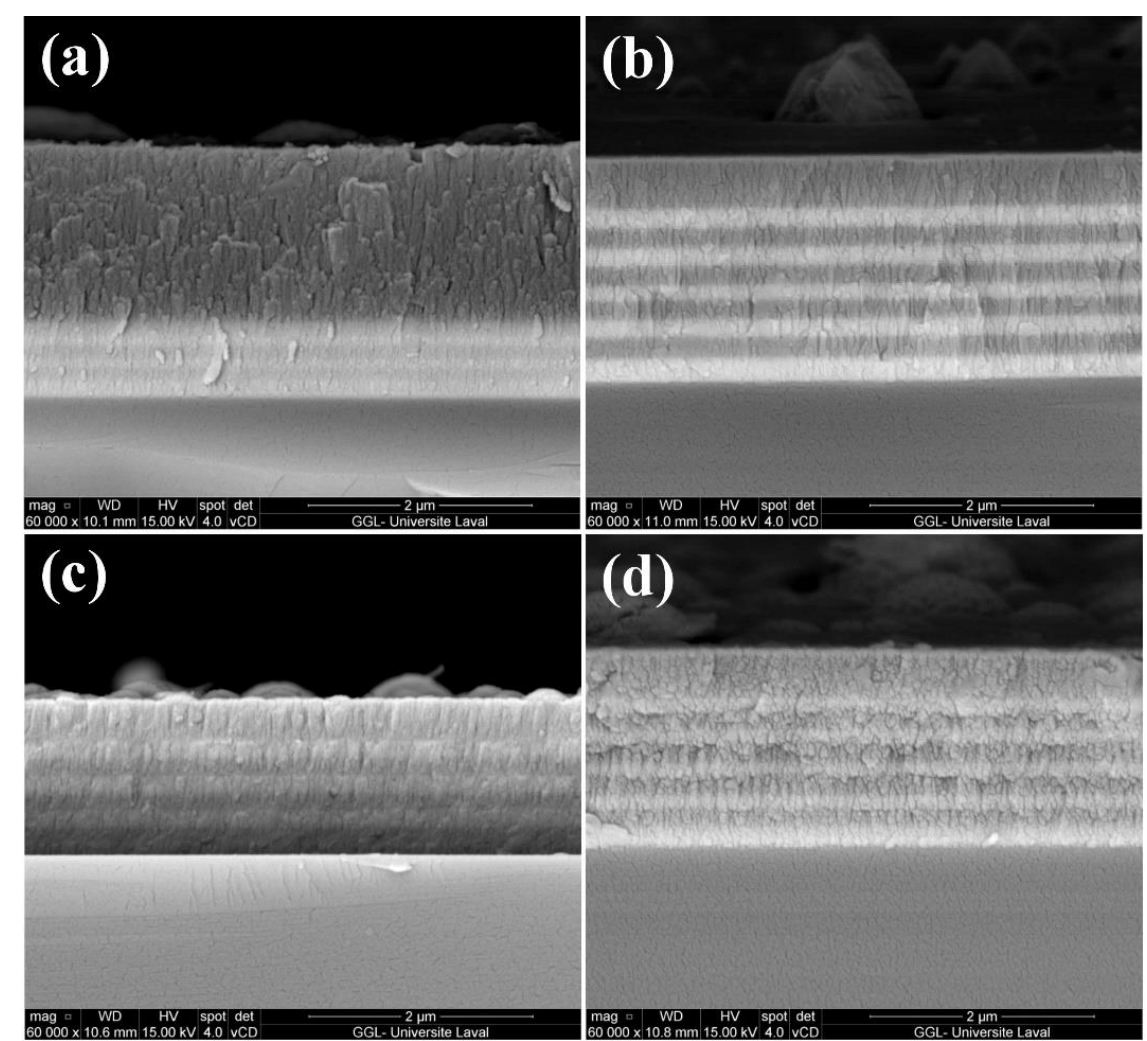
Figure 8. SEM micrographs illustrating the fracture cross-section views of as-deposited coating on silicon wafer substrates ( a ) CrN/CrCN/DLC, ( b ) CrN/AlTiN, ( c ) CrN/CrCN, and ( d ) CrCN/TiSiCN.